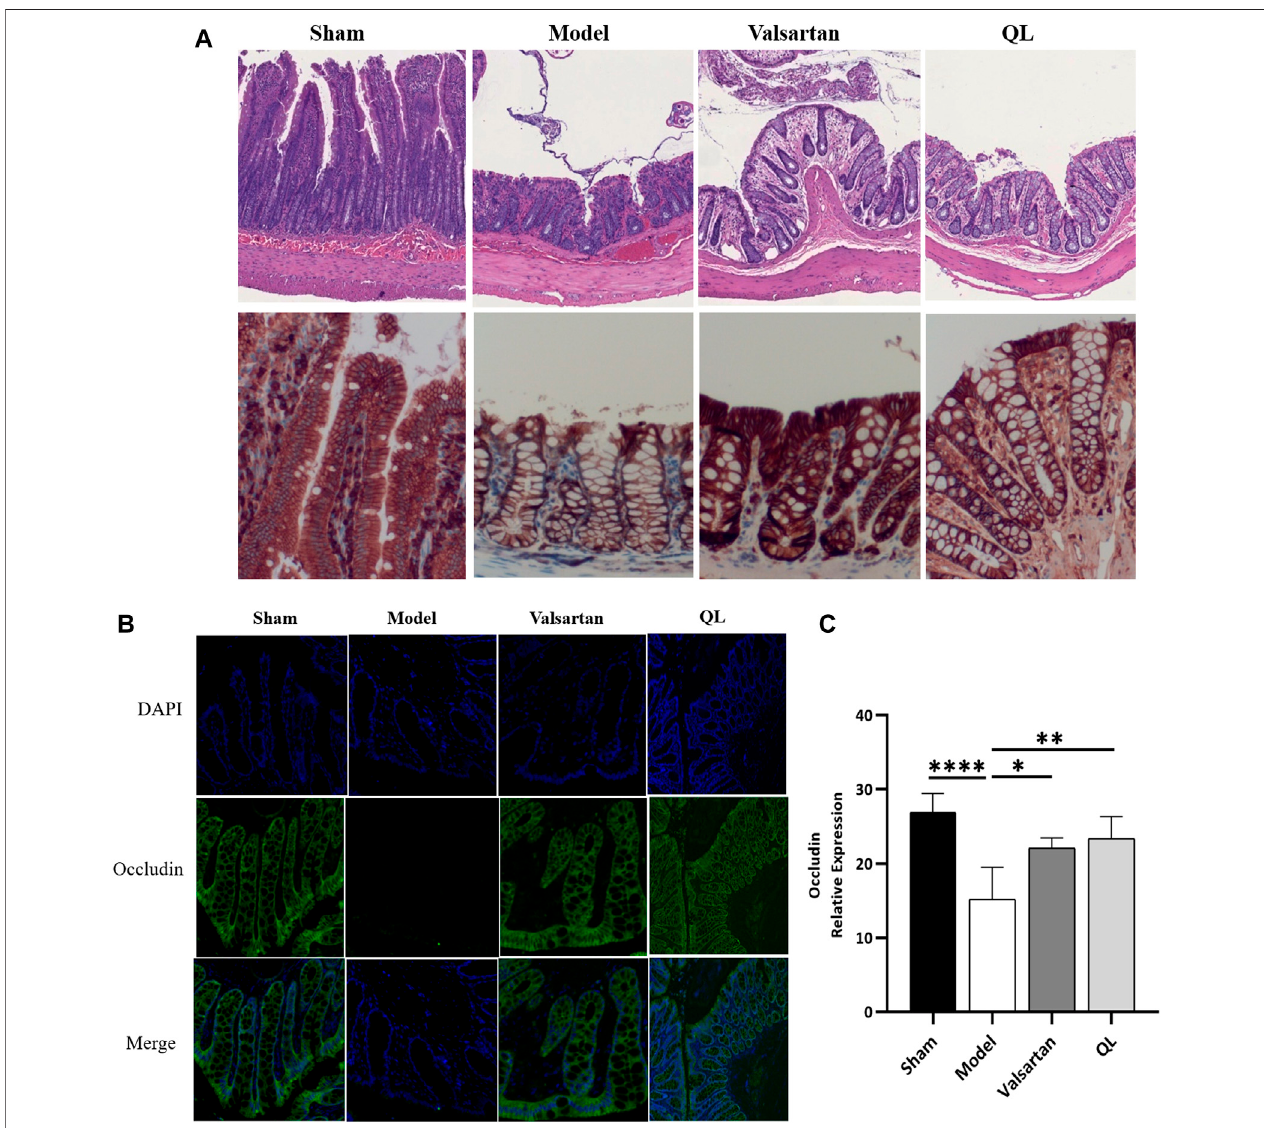
FIGURE 4 | QL ameliorates the pathological damage of the intestinal barrier in HF. (A) Pathological changes of the colonic mucosa under a light microscope with H&E staining (scale bar = 300 µm). (B,C) Expression of occludin detected with immuno fl uorescence staining. The data are the mean ± standard deviation ( (cid:1) x ± s ) (n = 5 or 6 per group); * p < 0.05, ** p < 0.01, and **** p <